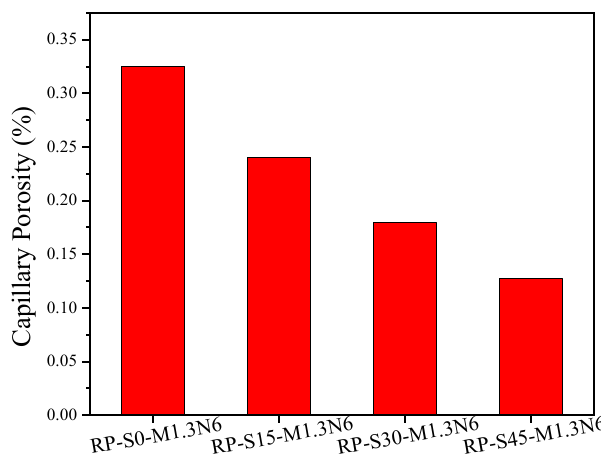
Figure 8. Capillary porosity of RPSG with different slag contents.